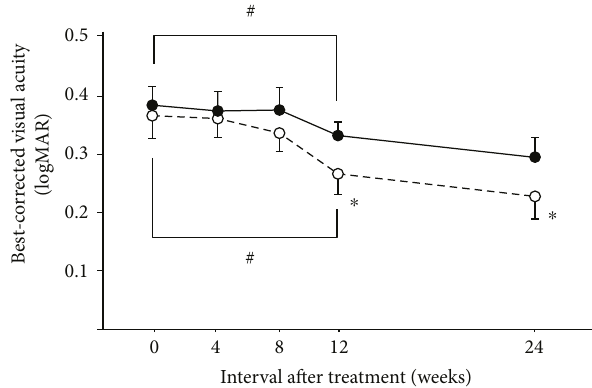
Figure 5: Changes in best-corrected visual acuity (BCVA) (logarithm of the minimum angle of resolution (logMAR)) after focal laser treatment in the MIG-PC and FG-PC groups. Data represent the mean ± standard error (SE). # p < 0 05 (compared with RT at PC initiation) and ∗ p < 0 05 (MIG-PC group versus FG-PC